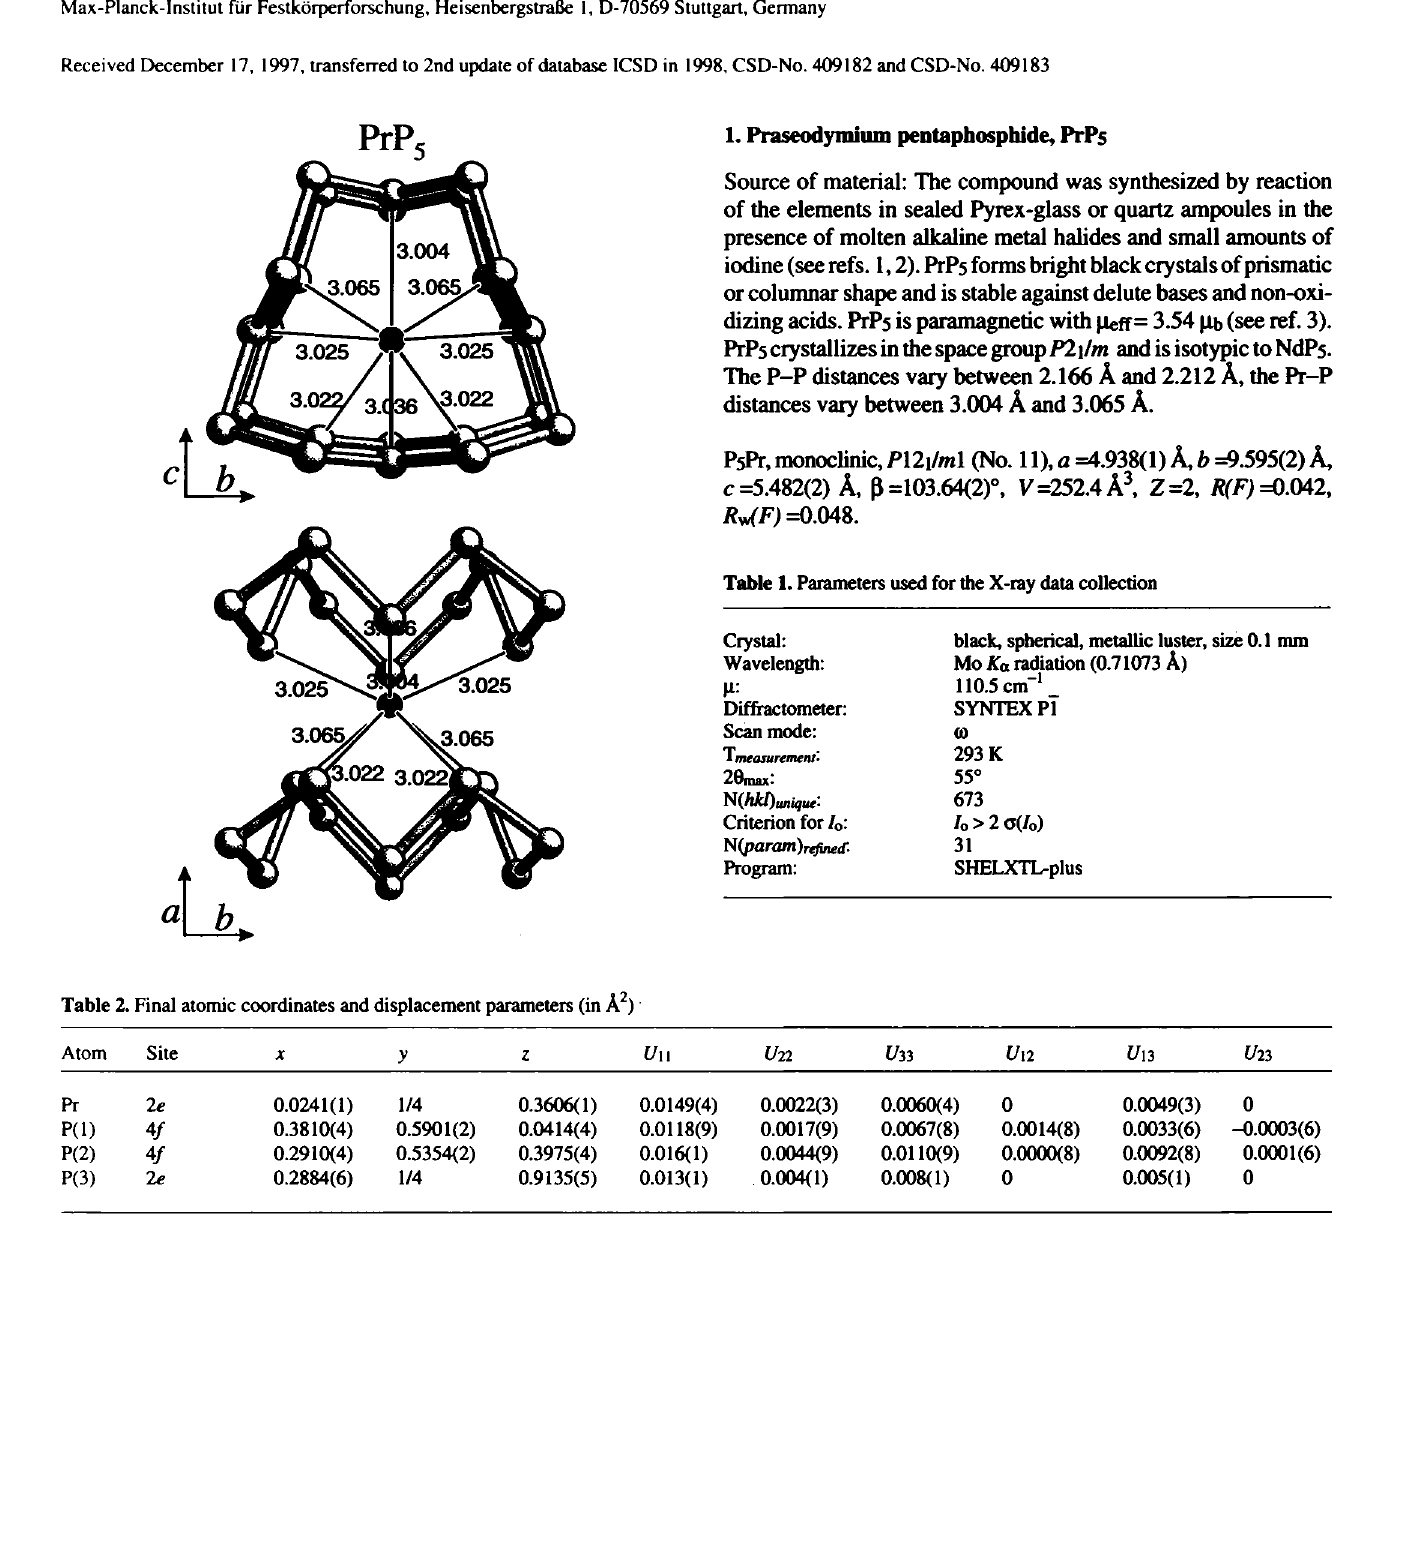
Table 2. Final atomic coordinates and displacement parameters (in h}) Atom